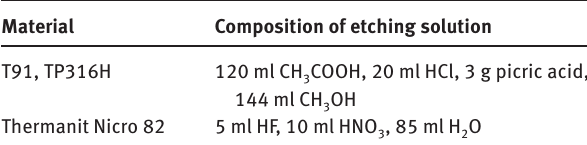
Fig. 1: Schematic cross-weld (c-w) sampling of tubular welded joint T91/TP316H. Table 2: Etchants used for the etching of dissimilar